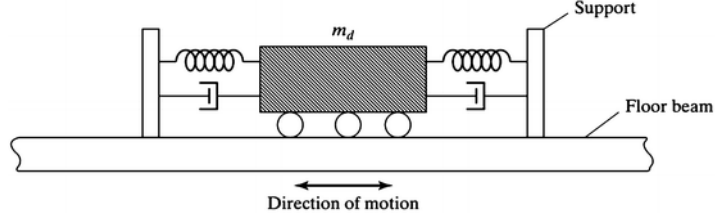
Figure 1. A passive TMD mounted on the platform of the